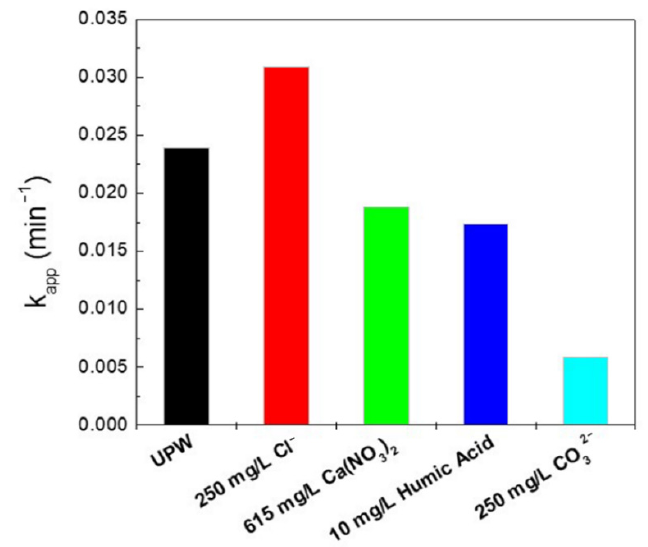
Figure 13. Effect of the addition of bicarbonates (CO 32 − ), chloride, calcium nitrate (Ca(NO 3 ) 2 ) or humic acid on 500 µ g/L SMX degradation with 100 mg/L biochar (RHB 850) and 500 mg/L SPS at inherent pH.